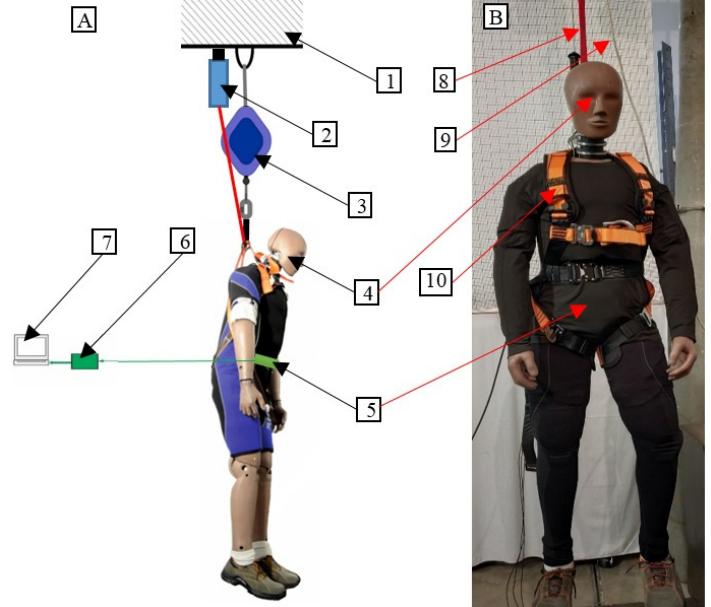
Figure 2. ( A ) The stand for testing the behavior of the manikin during fall arrest. ( B ) The